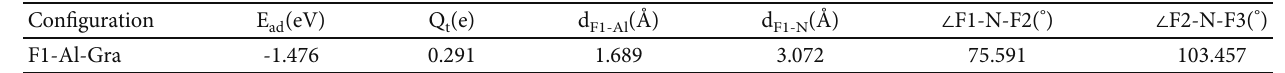
adsorbed on Al-Graohene. 3